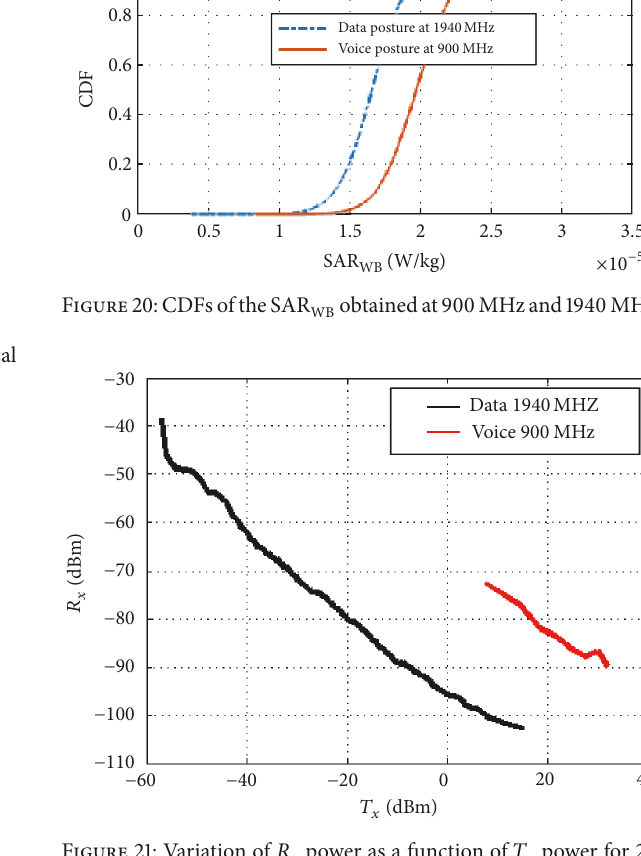
Figure 21: Variation of 𝑅 𝑥 power as a function of 𝑇 𝑥 power for 2G (900 MHz) and 3G systems